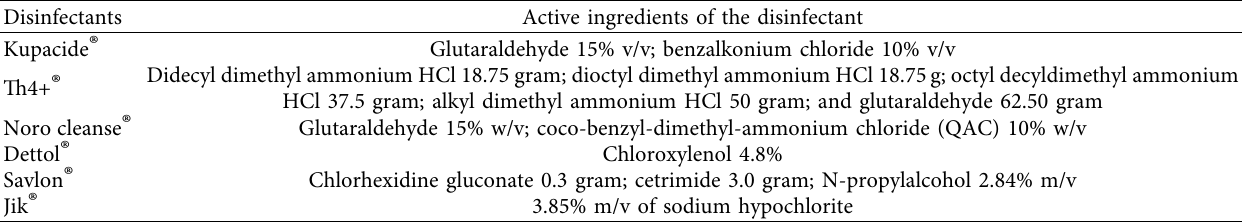
Table 1: Respective active ingredients of the tested